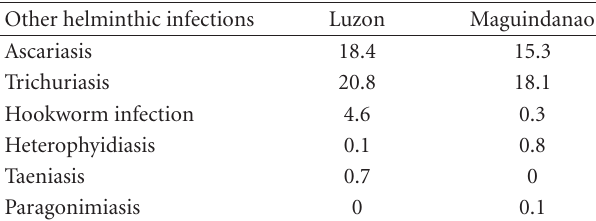
Figure 1: Prevalence of schistosomiasis in Luzon, 2007.